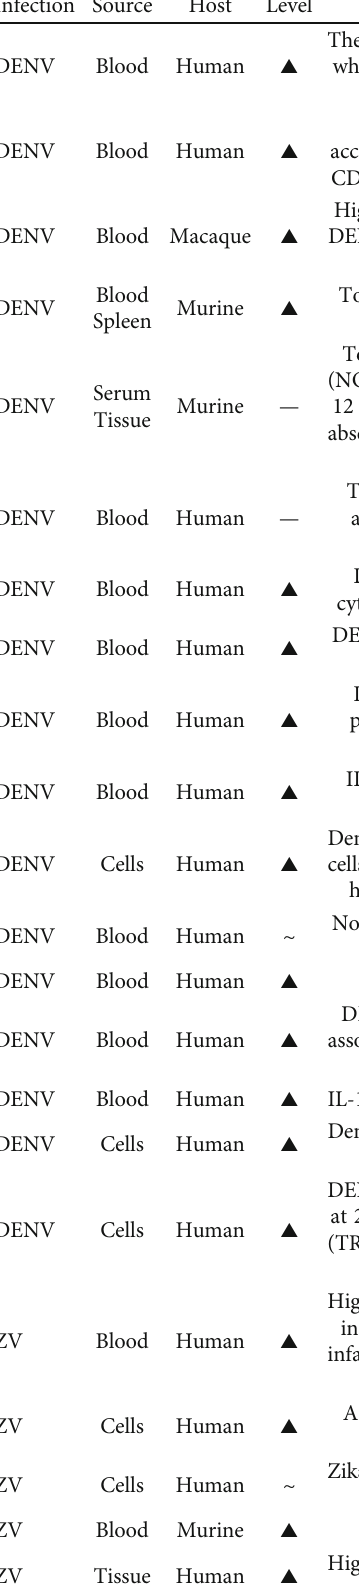
Table 2: IL-18 production in fl avivirus infection and its immune responses. Infection